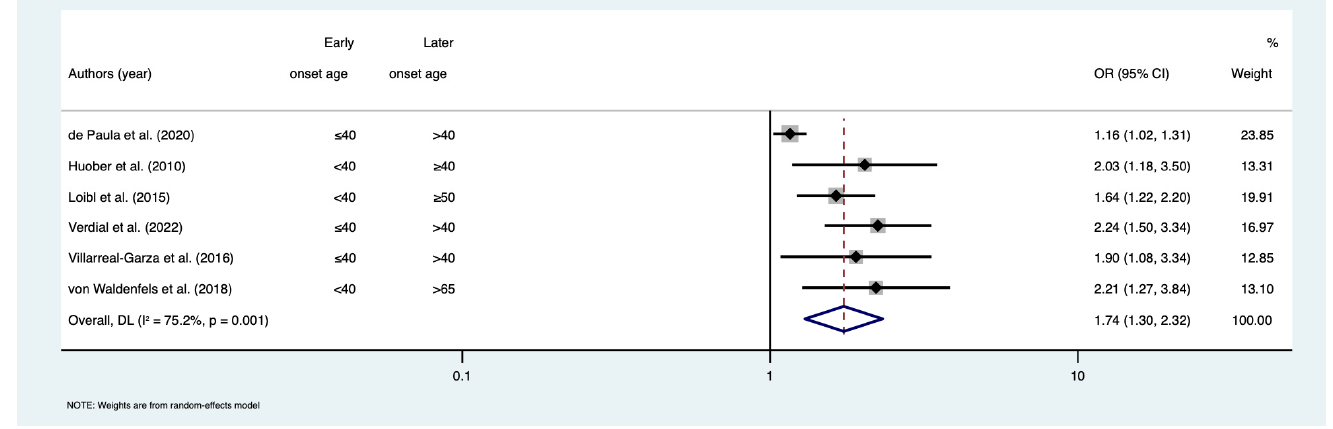
Figure 6. Forest plot for meta-analysis of pathological complete response (pCR). Odds ratios less than 1 show lower odds of achieving pCR in early-onset age group; Odds ratios greater than 1 show higher odds of achieving pCR in early-onset age group. References [24,26,37,43–45]. Abbreviations: CI = confidence interval; OR = odds ratio.